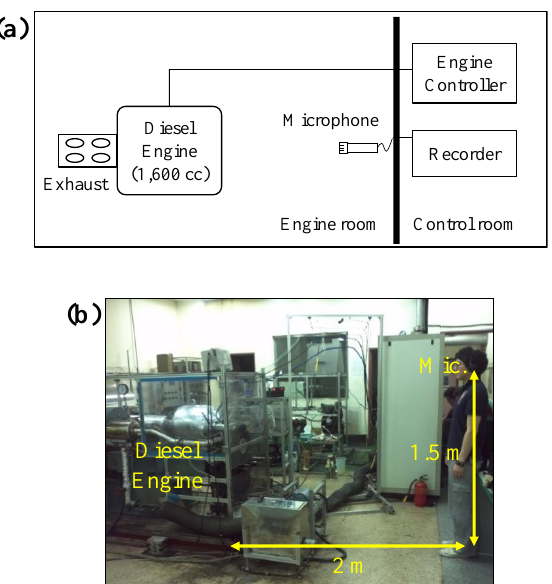
Figure 4. Experimental setup for the reference noise acquisition: ( a ) schematic diagram of the engine and control room and ( b ) 1600-cc single-cylinder diesel engine and measurement location of microphone. The diesel engine operated at various rotational frequencies as the noise signal was measured. The impulsive signal generated when the diesel engine was started was also measured.